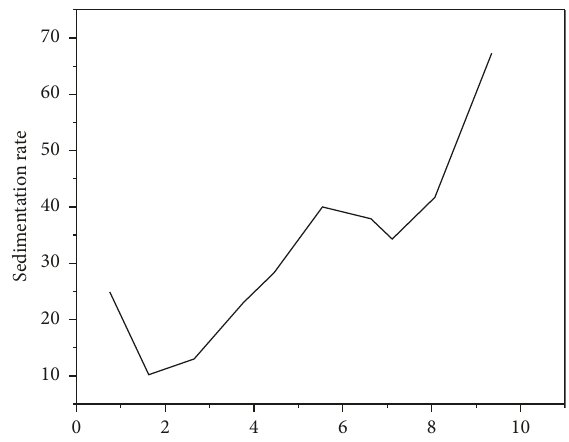
Figure 3: The relationship between the percentage of mass used for dispersant BYK-163 and the sedimentation rate.